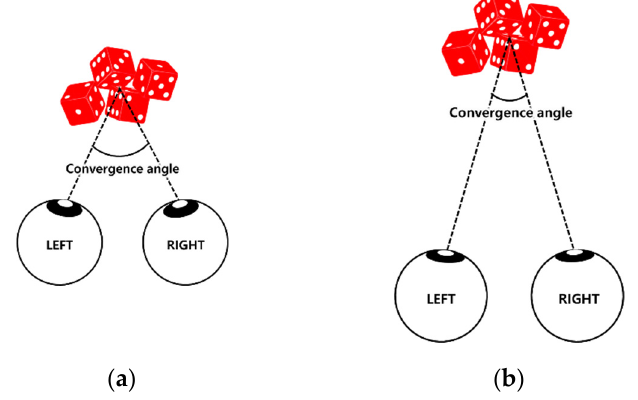
Figure 1. Convergence angle of human eye: ( a ) wide; ( b ) narrow.